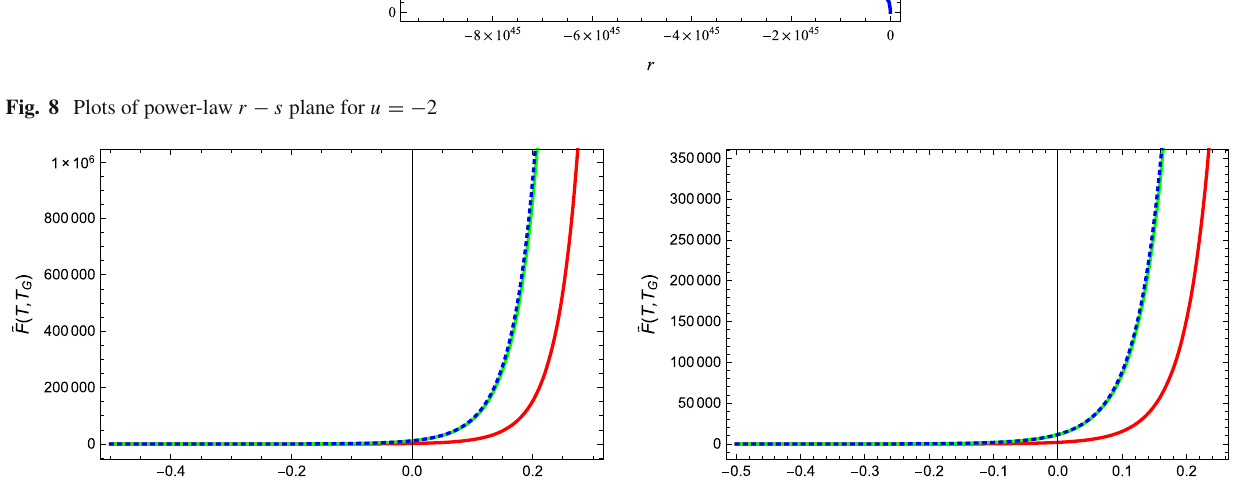
Fig. 8 Plots of power-law r − s plane for u = − 2